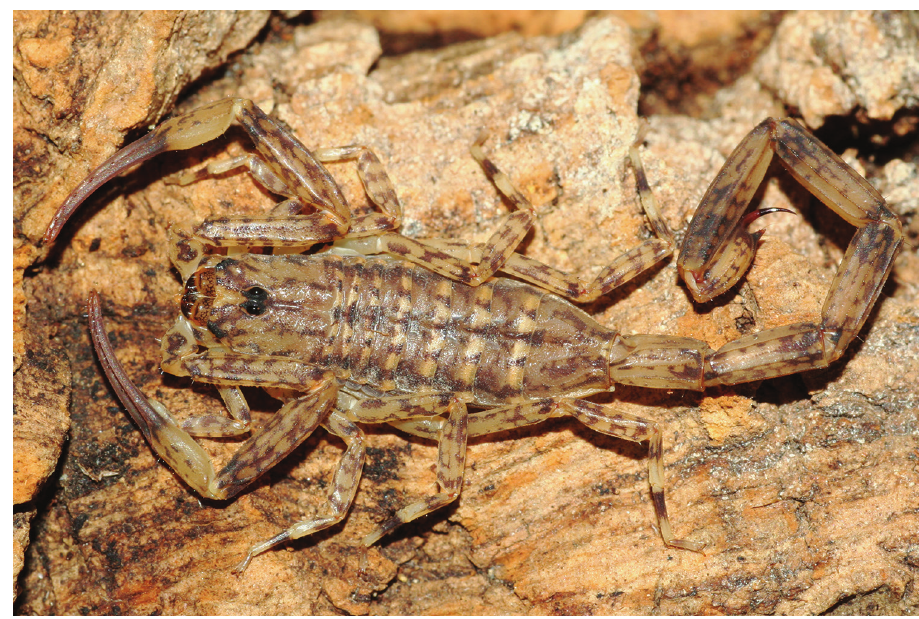
Figure 8. Isometrus maculatus , female from St. Jean du